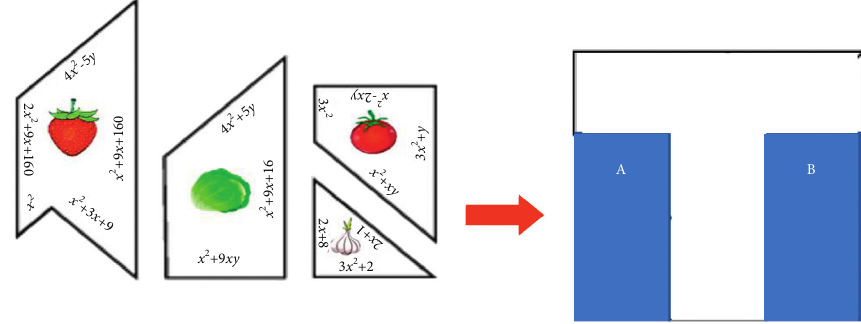
Figure 1: Illustration of sample